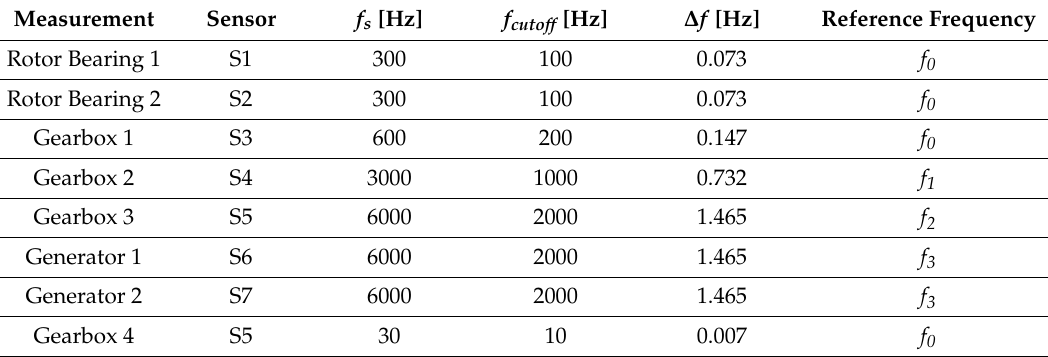
Table 5. Measurements, sensors, sampling frequencies, cut-off frequencies, frequency resolutions, and reference